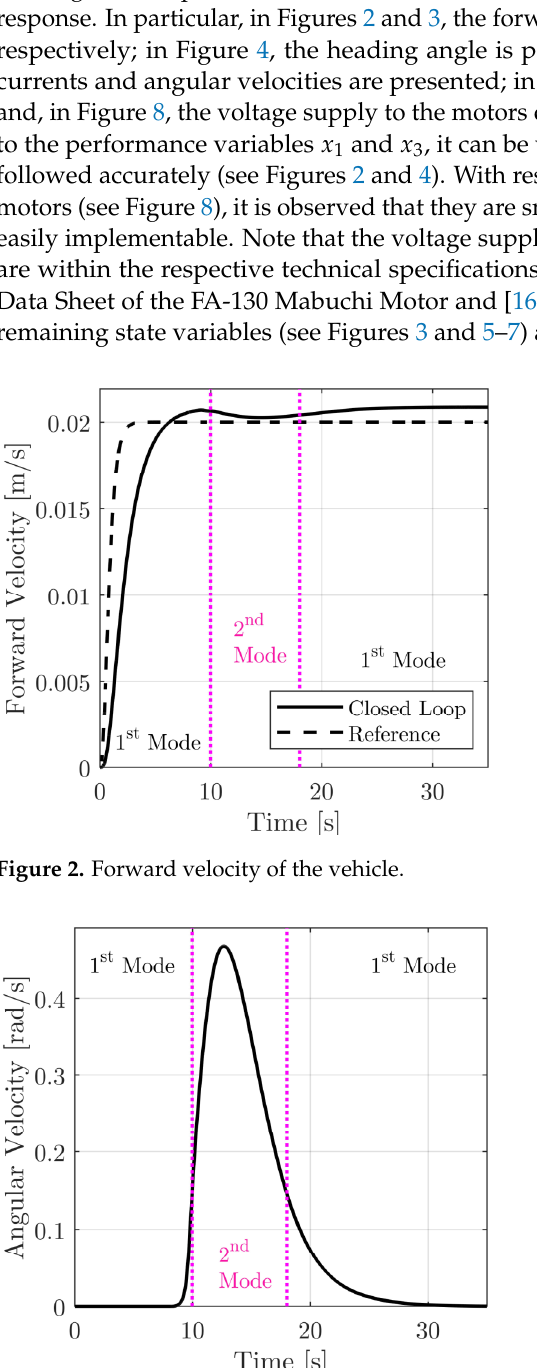
Figure 4. Heading angle of the vehicle. Figure 5. Motor currents.